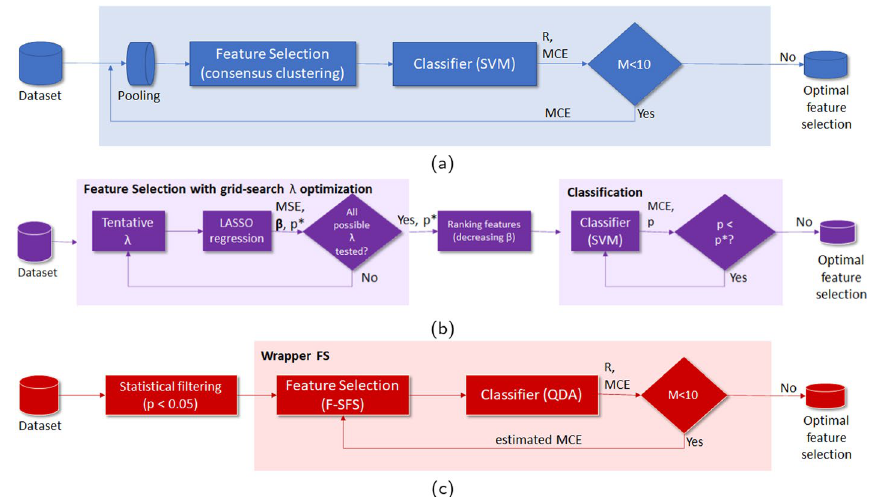
Fig. 1 Block schemes for the three feature selection algorithms: (a) FeSC, (b) LASSO, (c) pFSFS